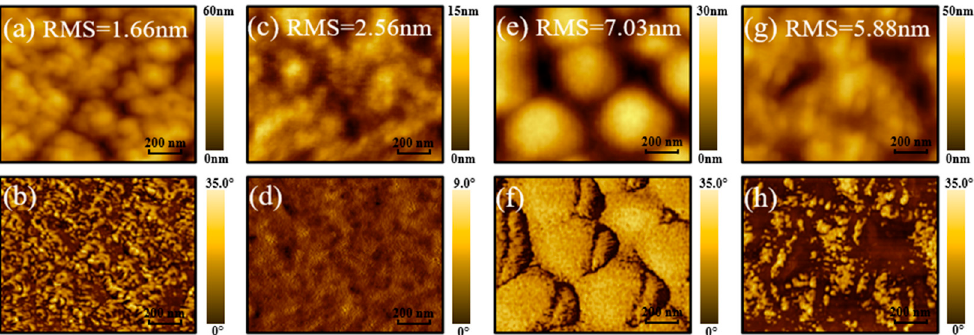
Figure 4. Representative AFM topography ( up ) and phase ( down ) images for PTB7-based active layers. ( a , b ) PTB7, ( c , d ) DIO-treated PTB7, ( e , f ) PTB7:PC 71 BM, ( g , h ) DIO-treated PTB7:PC 71 BM, the active layer was dried under the vacuum level of 10 − 5 Pa for 12 h.